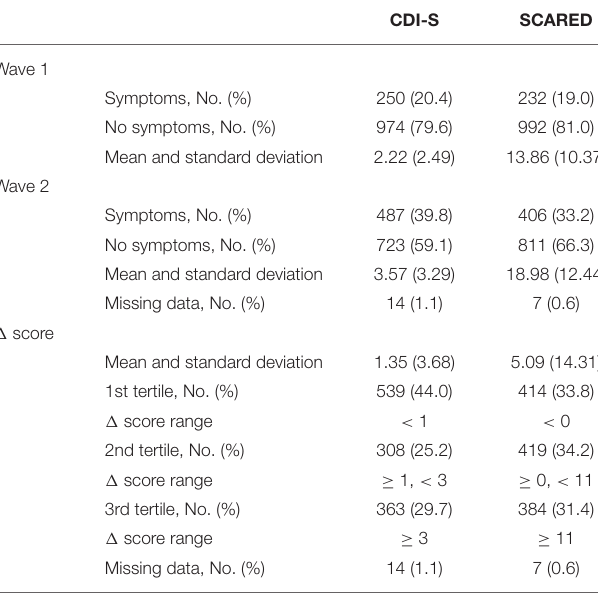
TABLE 1 | Demographic characteristics of children who completed both surveys. TABLE 2 | Distribution of scale scores of children who completed both surveys.